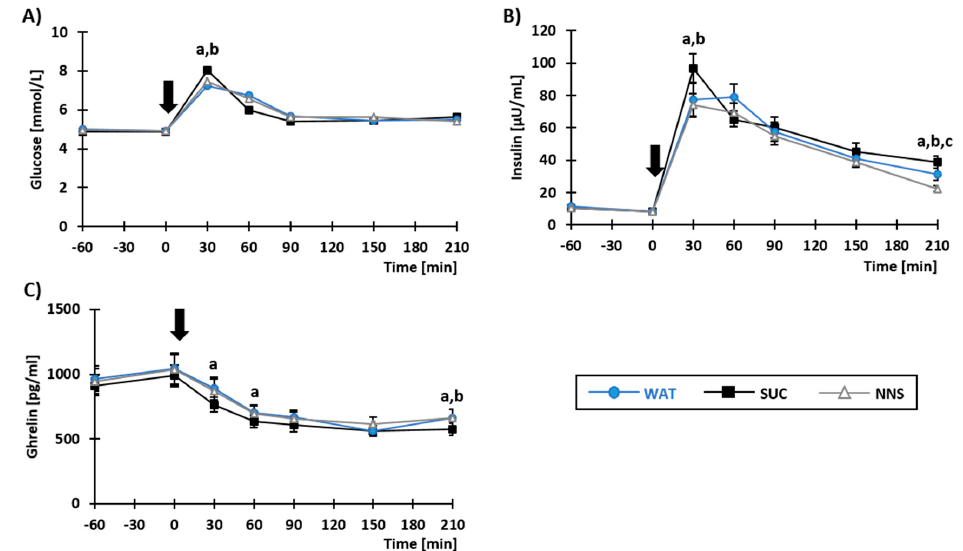
Figure 2. Plasma concentrations of glucose ( A ), insulin ( B ), and ghrelin ( C ) in response to beverage and concomitant meal ingestion at T = 0 min, indicated by a black arrow. Data are presented as mean ± SEM. a,b,c : p < 0.05 for post-hoc paired t -tests (two-tailed), respectively between SUC-WAT, SUC-NNS, and WAT-NNS. WAT, SUC, NNS: Water-, Sucrose-, NNS-beverage conditions.